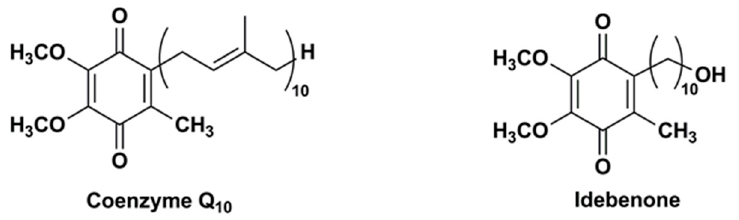
Figure 1. Chemical structures of CoQ10 and IDE.